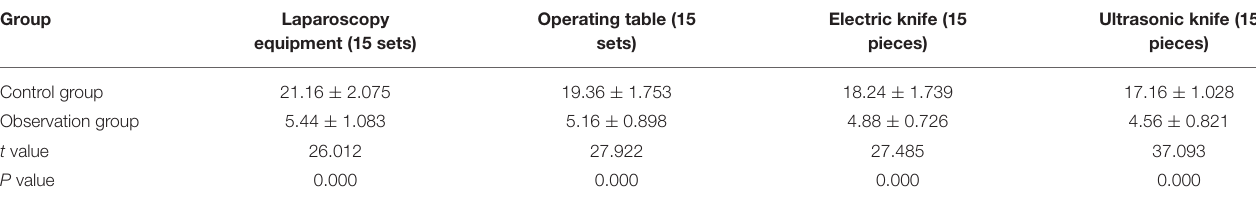
TABLE 3 | Comparison of the time spent on searching for operating room equipment between the two groups (min, X ± S).